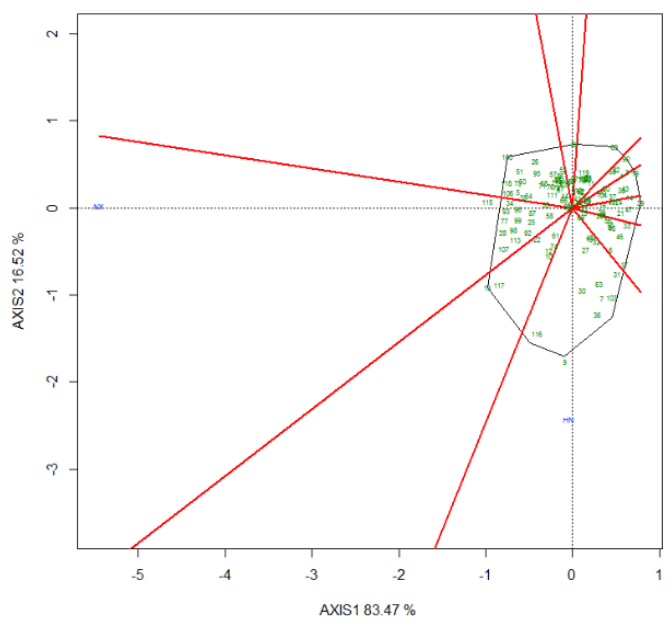
Figure 7. Suitable ground diameter genotypes for the mega − environment.